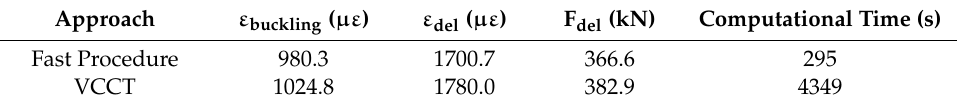
Figure 11. Comparison of proposed approach and virtual crack closure technique (VCCT) in terms of normalized energy release rate (ERR) distribution along delamination front. Table 2. Critical propagation loads and computational time comparison.